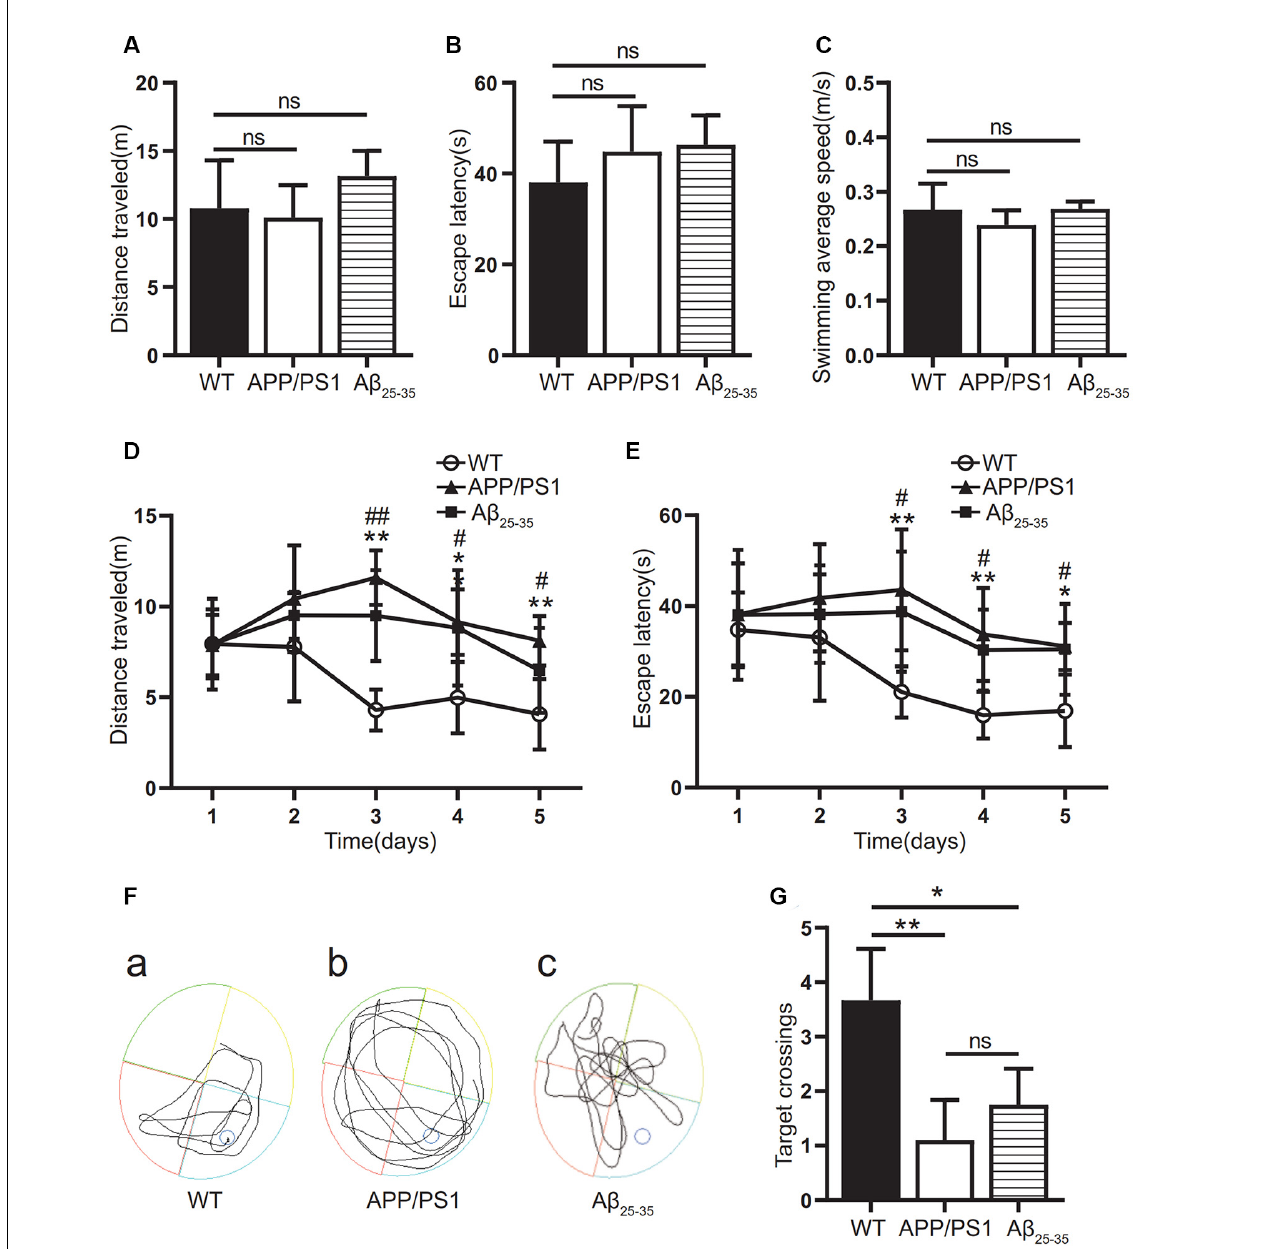
FIGURE 1 | Cognitive function of Alzheimer’s disease (AD) model mice. (A–C) The swimming distance, incubation period, and average swimming speed of the APP/PS1 group and A β 25–35 group mice were studied in the Morris water maze (MWM) experiment with a visual platform. (D,E) The swimming distance and latency of the APP/PS1 group and the A β 25–35 group in the MWM experiment with a hidden platform (WT vs. APP/PS1 group: * p < 0.05, ** p < 0.01; WT vs. A β 25–35 group: # p < 0.05, ## p < 0.01; n = 10). (F) Swimming path map of the APP/PS1 group and A β 25–35 group mice in the water tank. (G) The number of platform crossings of the A β 25–35 group and APP/PS1 group mice after removing the platform (* p < 0.05, ** p < 0.01; “ns” means there is no significant difference; n =